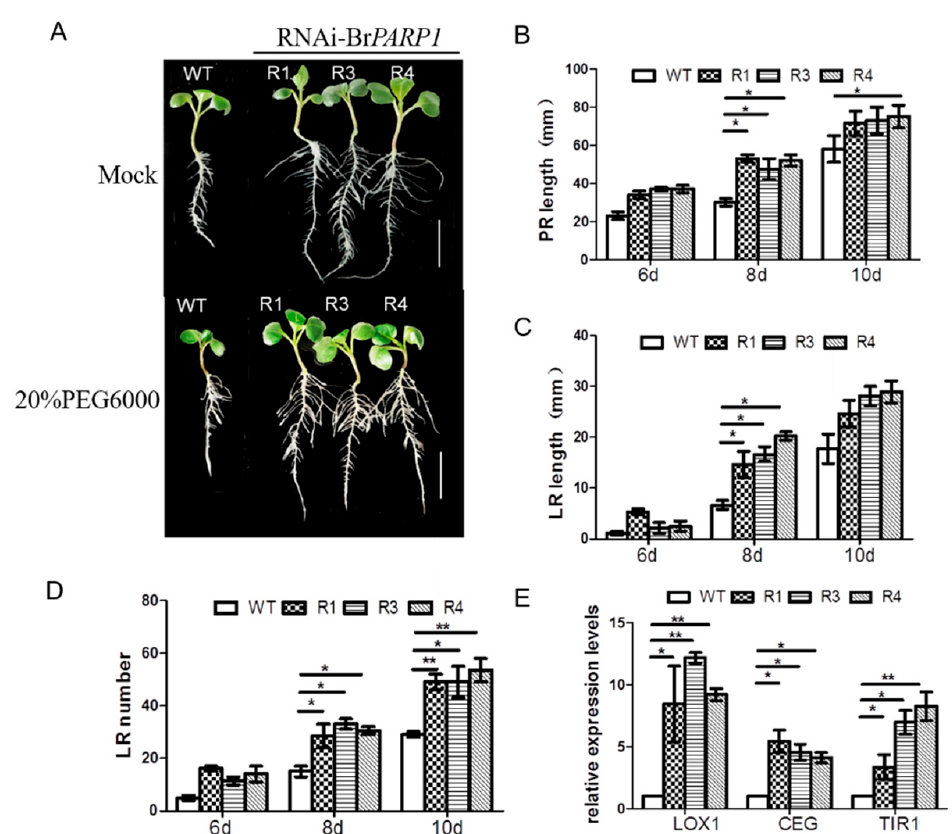
Figure 4. Analysis of the effect of Br PARP1 on root growth. ( A ) Comparison of the root system of WT and RNAi-Br PARP1 transgenic plants under normal conditions and after 20% PEG6000 treatment. Bar = 10 mm. ( B ) Principal root length analysis of WT and RNAi-Br PARP1 transgenic plants at 6 days, 8 days, and 10 days. ( C ) Lateral root length analysis of WT and RNAi-Br PARP1 transgenic plants at 6 days, 8 days, and 10 days. ( D ) Lateral root number analysis of WT and RNAi-Br PARP1 transgenic plants at 6 days, 8 days, and 10 days. ( E ) Analysis expression of lateral root-related genes. LOX1: Lectin-like oxidized low-density lipoprotein receptor-1; CEG: Clusters of Essential Genes; TIR1: Transport Inhibitor Response 1 (** p < 0.01, * p < 0.05).